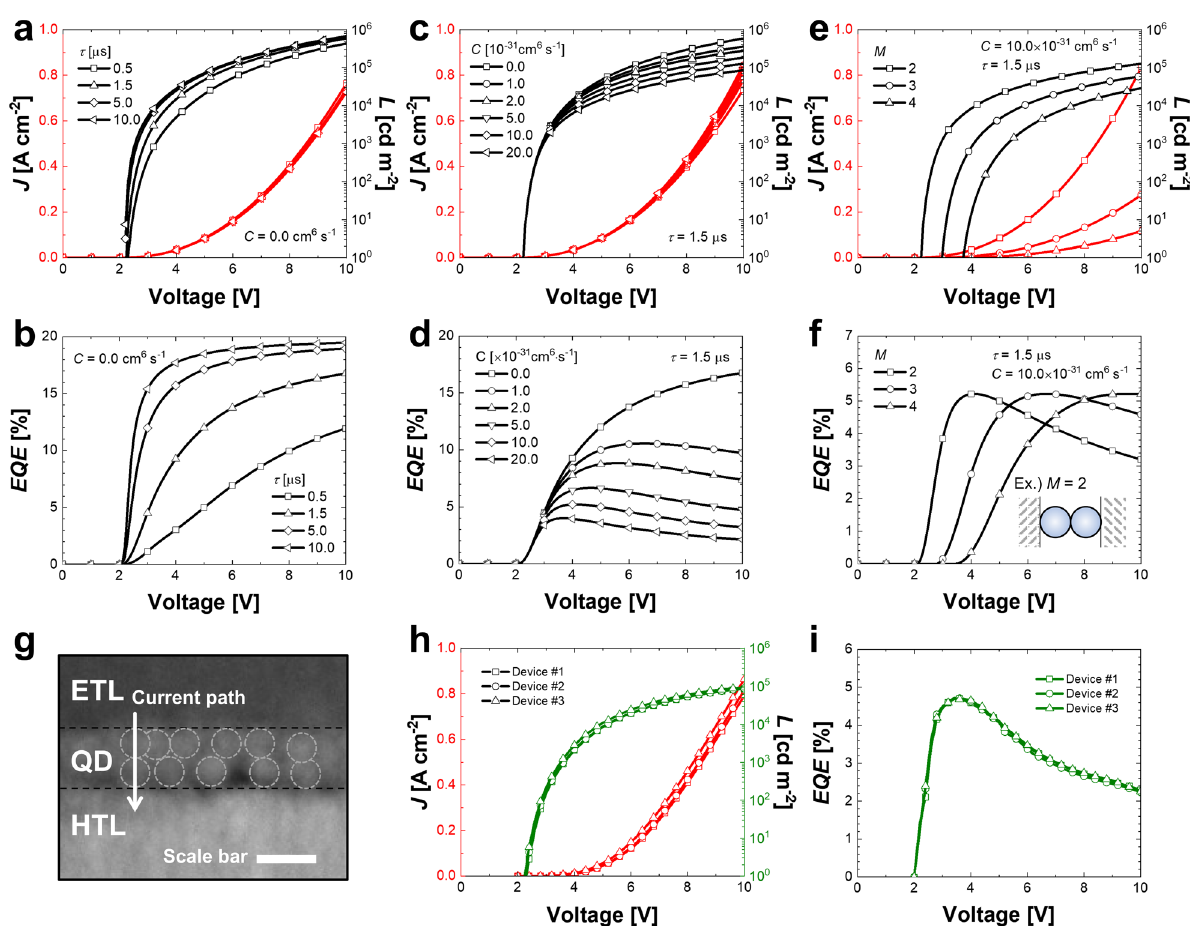
Fig. 3 Variations of the simulated voltage dependences of electro-optical properties of QD-LEDs. Luminance, current density and EQE curves for a – b different SRH recombination lifetimes, for c – d different Auger capture probabilities and for e – f different number of QD layers in EML. LEE is considered 20% for the calculation of the EQE curves. g TEM image of the cross-section of QD layer. The length of scale bar is 10 nm and the average diameter of QDs is estimated to be around 5 nm. h – i Luminance, current density and EQE curves obtained experimentally from the green QD-LED samples fabricated in this study. The electro-optical characteristic curves show quite similar behaviours to the simulated